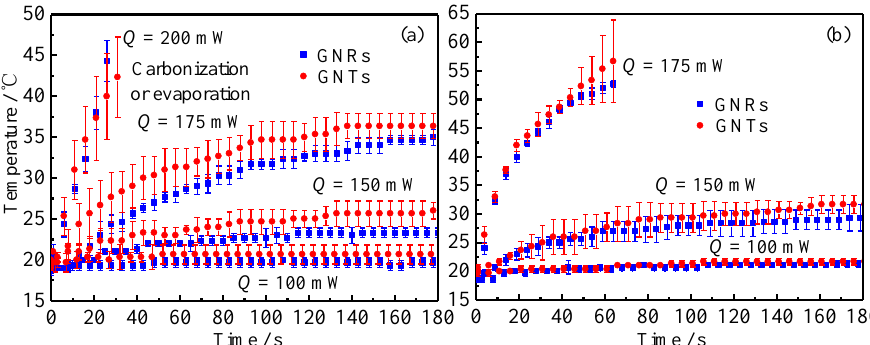
Figure 7. The impact of different kinds of gold nanoparticles, nanorods and nanotriangles, under different injection dosage: ( a ) 0.1 mL and ( b ) 0.2 mL.